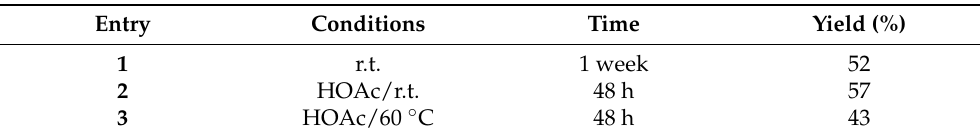
Table 1. Optimization of reaction conditions of 10b to afford 11b ; all procedures were performed in DMF.